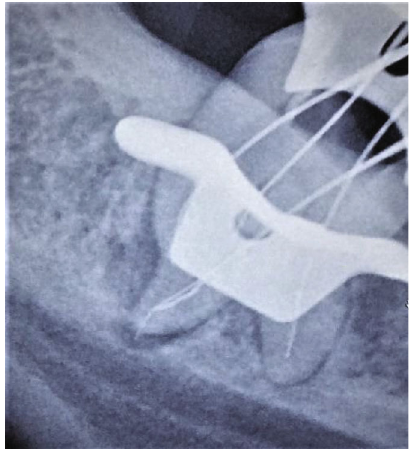
Figure 2: File bypass/working